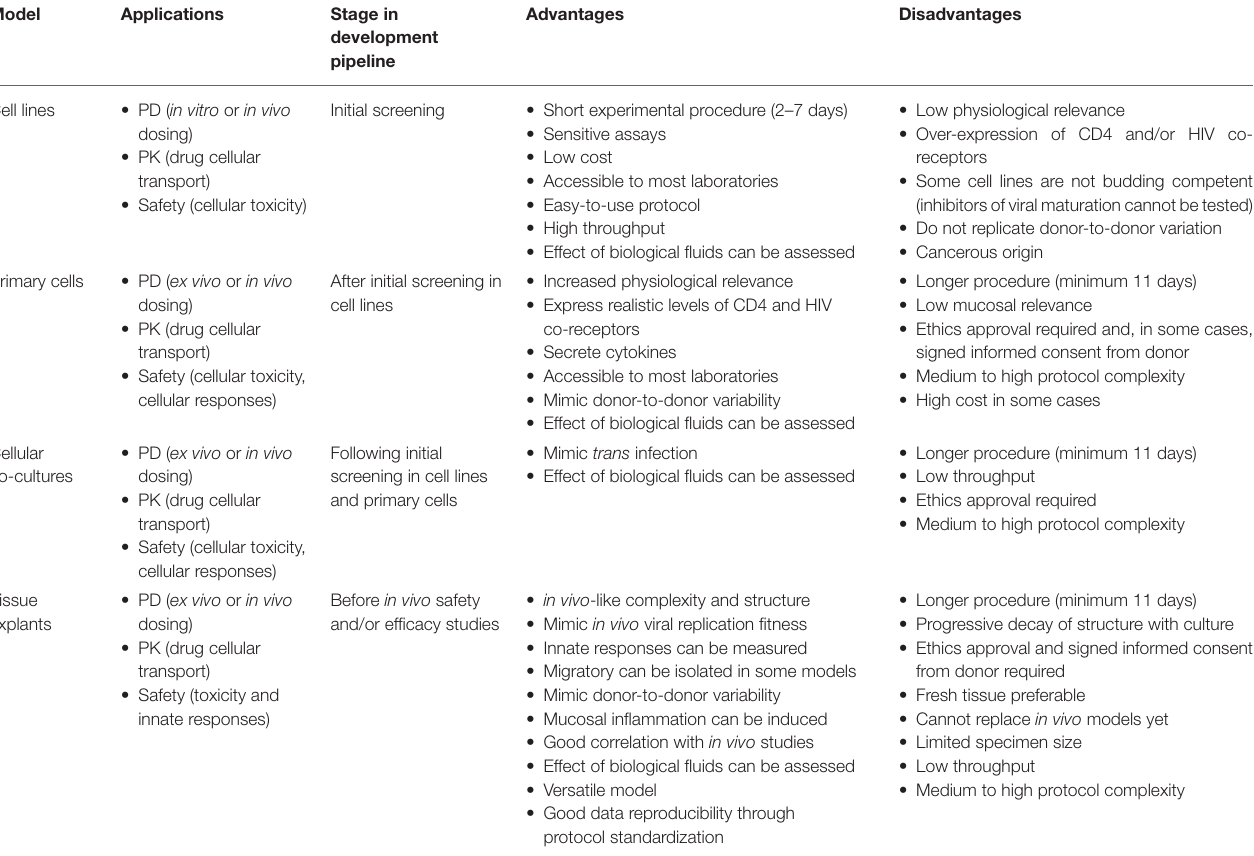
TABLE 1 | Applications of current in vitro and ex vivo models for development of HIV-prevention strategies.